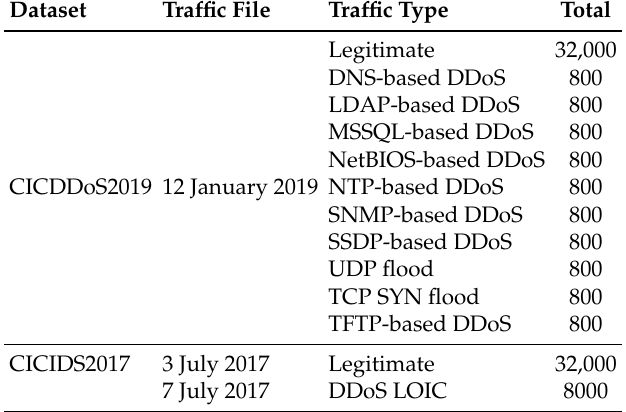
Table 3. DDoS attack types and the corresponding number of instances for each dataset. Dataset Traffic